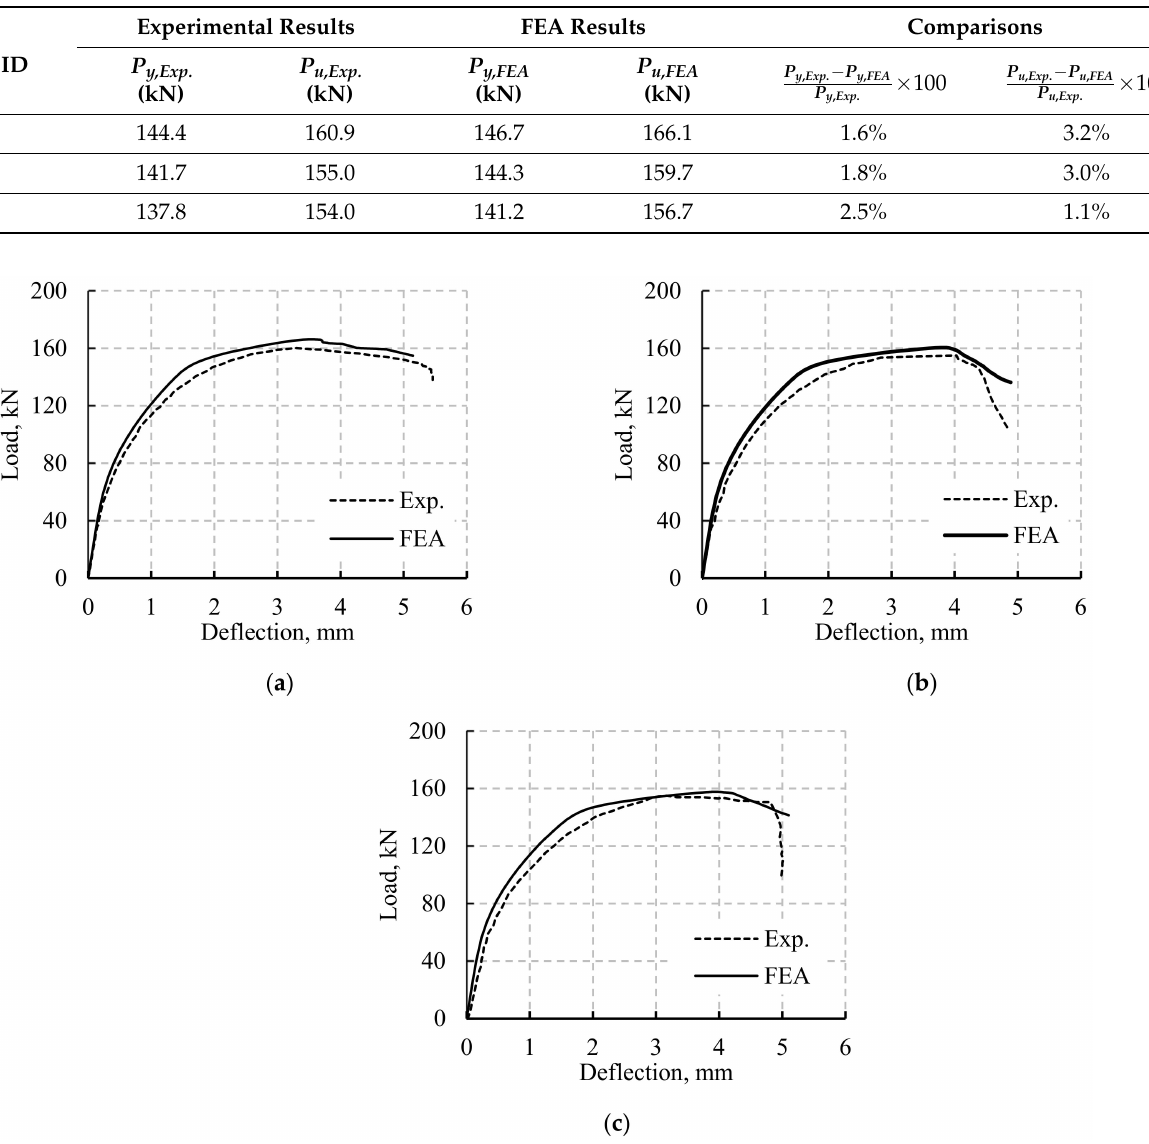
Figure 5. Compression between the experimental and FEA model results (verification): ( a ) Beam B1; ( b ) Beam B2; ( c ) Beam